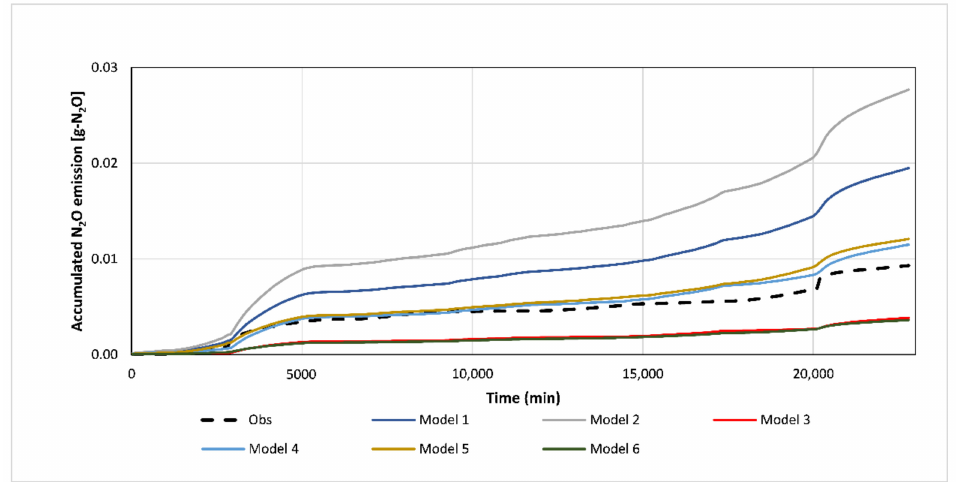
Figure 10. Experiment 1: temporal progression of the simulated cumulative N 2 O emissions in each of the soil gas diffusivity models with the observed emissions.